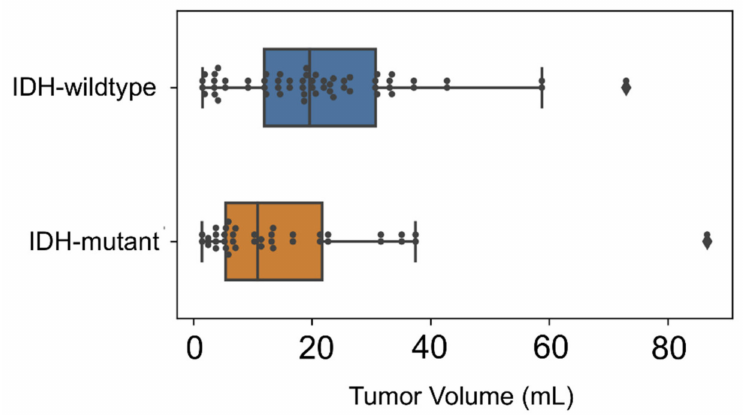
Figure 6. Distribution of tumor volumes in our patient cohort. Boxplots representing tumor volumes of the patient cohort. Patients with isocitrate dehydrogenase (IDH)-wildtype gliomas (blue) presented larger volumes than patients with IDH-mutant gliomas (orange).